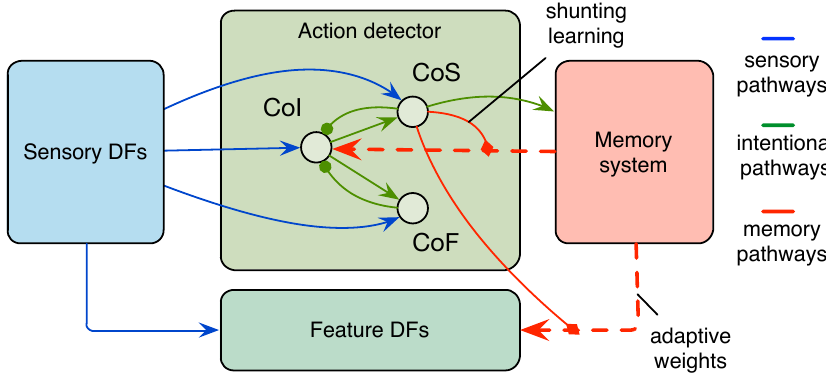
Figure 1: The parsing model. Lines with arrow heads denote excitatory connections. Lines ending in circles denote inhibitory connections. Red lines are learned memory traces, black lines are shunting terms controlling learning. See text for details.